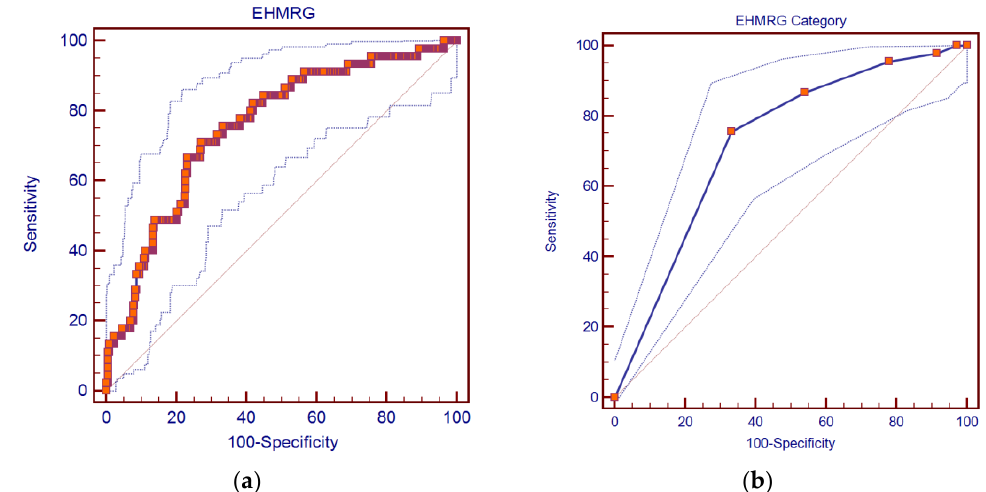
Figure 1. ROC curves of: ( a ) EHMRG score, considered as a continuous variable (AUC: 0.753; 95%CI: 0.710 – 0.793; p < 0.0001); ( b ) EHMRG score, considered as a categorical variable (AUC: 0.727; 95%CI: 0.683 – 0.768; p < 0.0001).